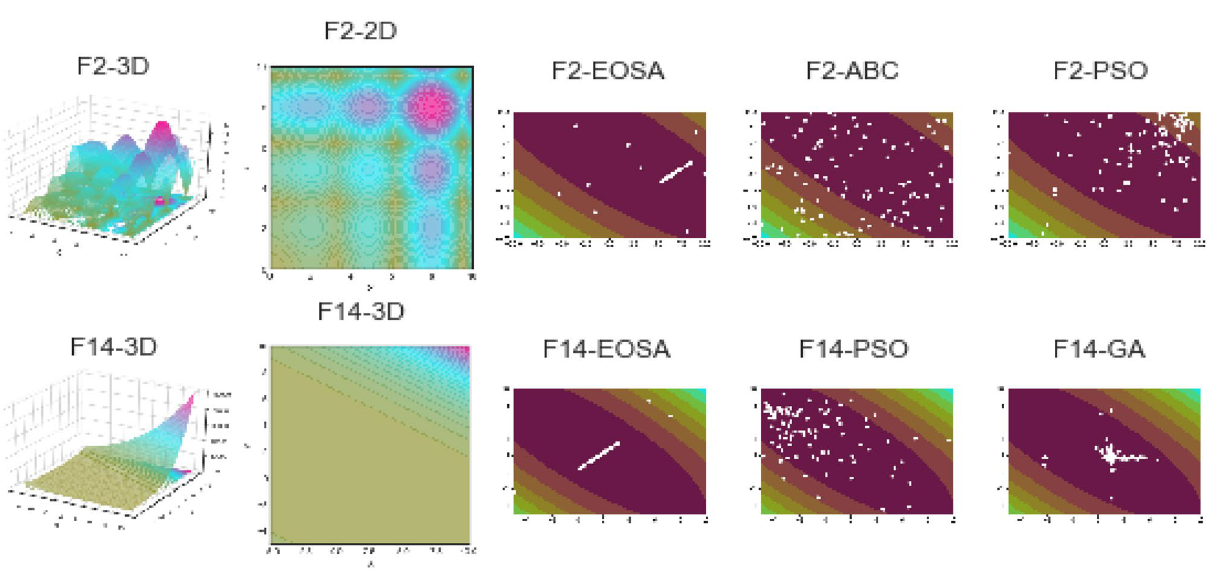
Figure 7. Comparison of convergence curves of the performance of EOSA, ABC, WOA, PSO, and GA optimization algorithms on all standard benchmark functions applied in this